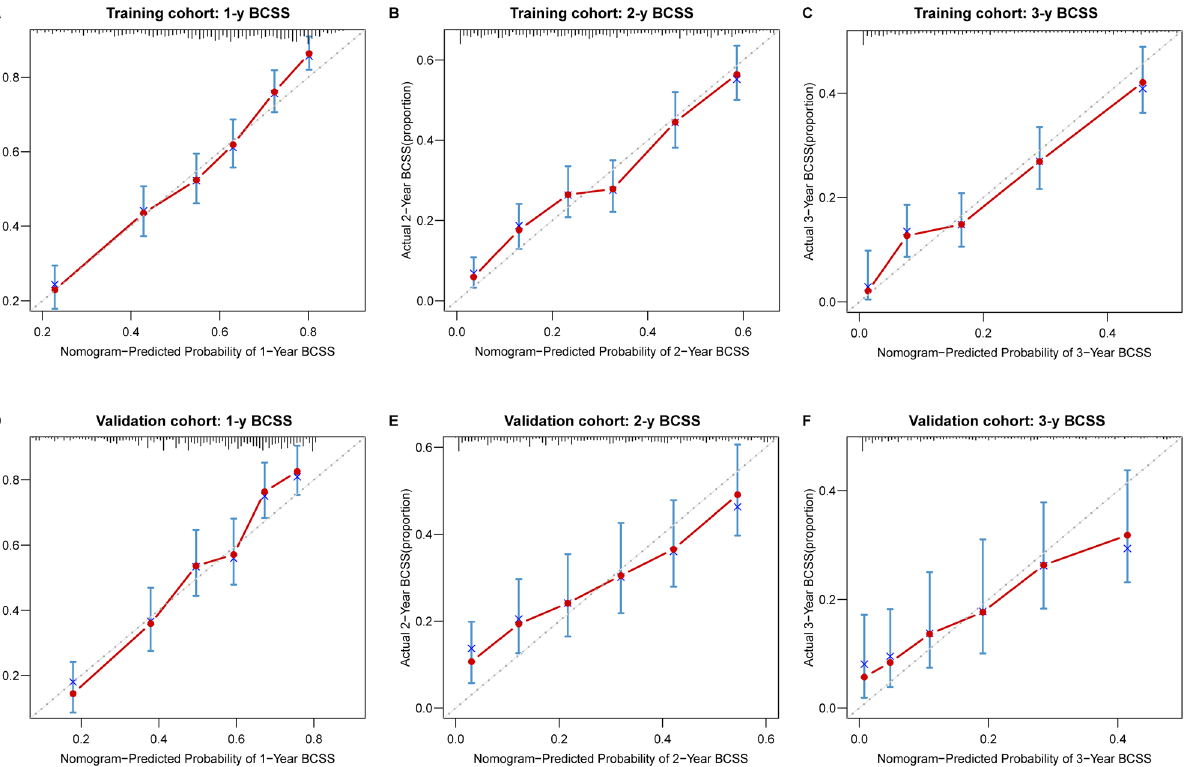
Figure 5. Calibration curves of 1-, 2-, and 3-year BCSS in training and validation cohorts. ( A – C ) Calibration curves of 1-, 2-, and 3-year BCSS in training cohort, respectively. ( D – F ) Calibration curves of 1-, 2-, and 3-year BCSS in validation cohort,